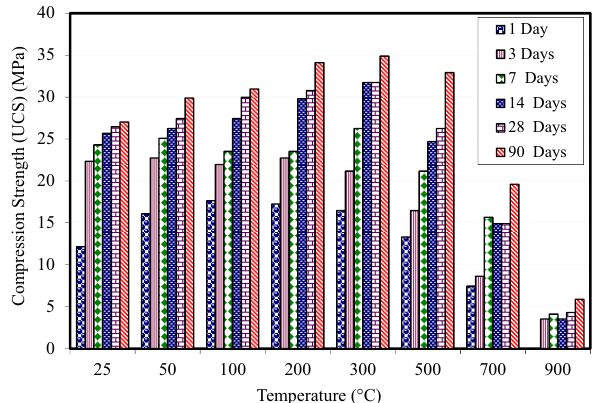
Figure 4: Changes in compressive strength at di ff erent temperatures ( 25 – 900°C ) with curing periods of 1 – 90 days.